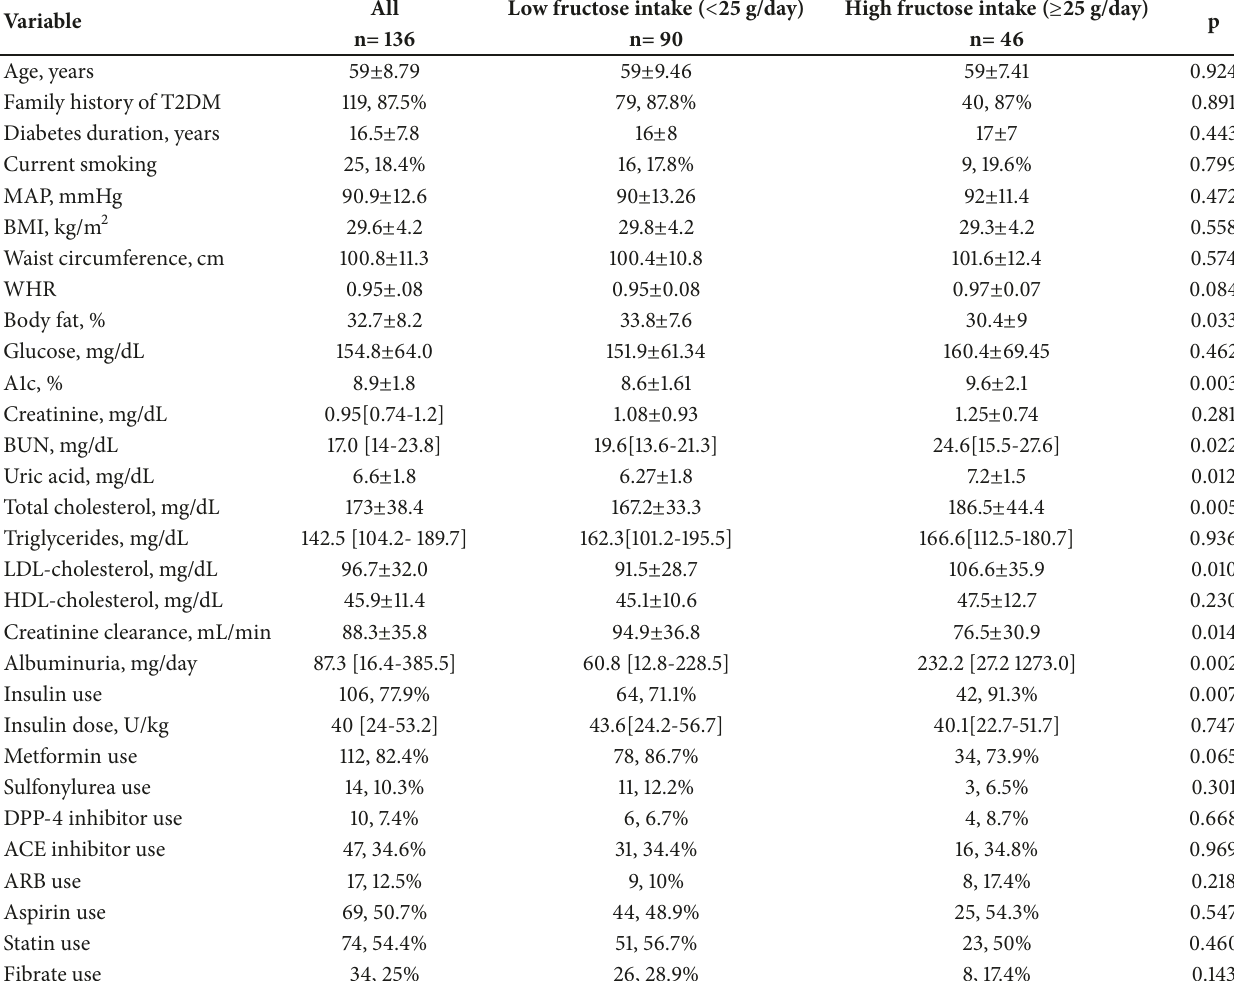
Table 1: Baseline characteristics of the subjects included in the study classified by fructose intake (n = 136).